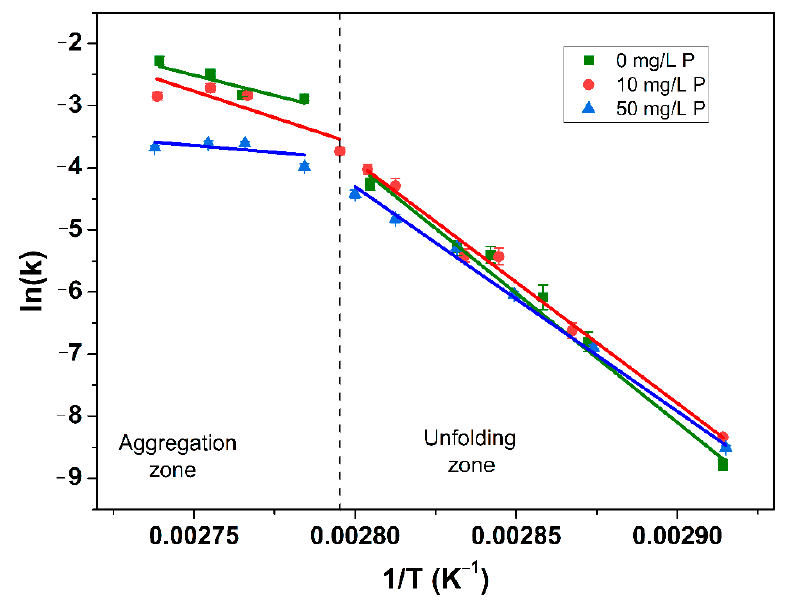
Figure 8. Arrhenius plot for the β -lg denaturation reaction with reaction order of 1.5 at various P concentrations. The solid lines correspond to the linear regressions of experimental data and the vertical dotted line correspond to 85 °C.